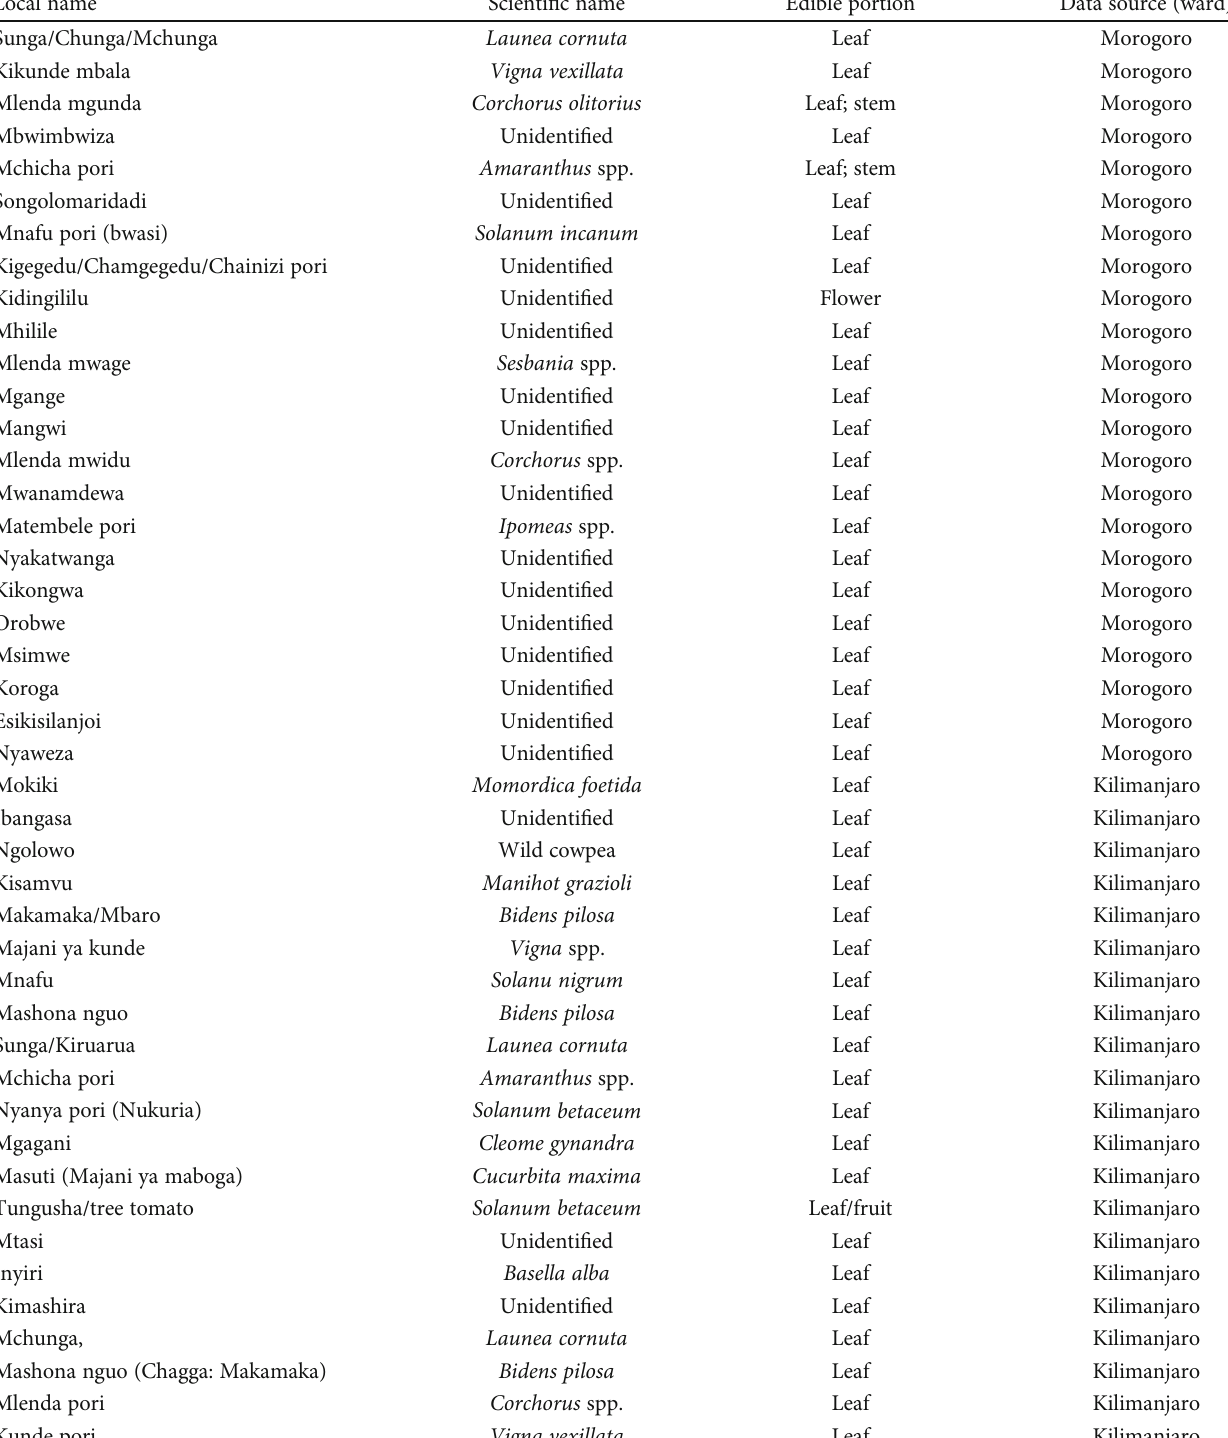
Table 1: List of underutilised vegetables reported by respondents in the study